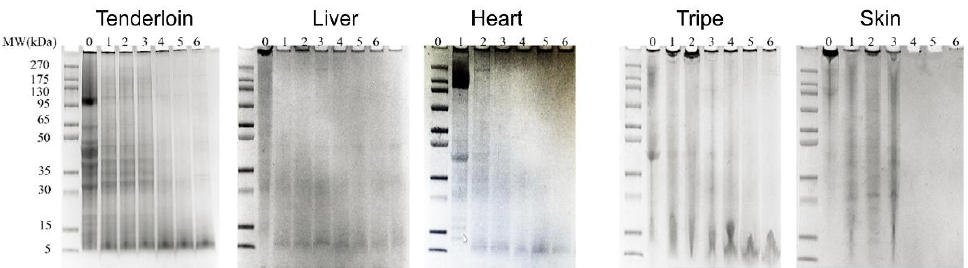
Figure 1. SDS-PAGE images of undigested and digested tenderloin and edible pork by-products. Lane 0 indicates undigested sample; lanes 1, 2 and 3 indicate samples after 15, 60 and 120 min of simulated gastric digestion, respectively; lanes 4, 5 and 6 indicate samples after 120 min of gastric digestion, which was followed by 15, 60 and 120 min of simulated intestinal digestion, respectively.